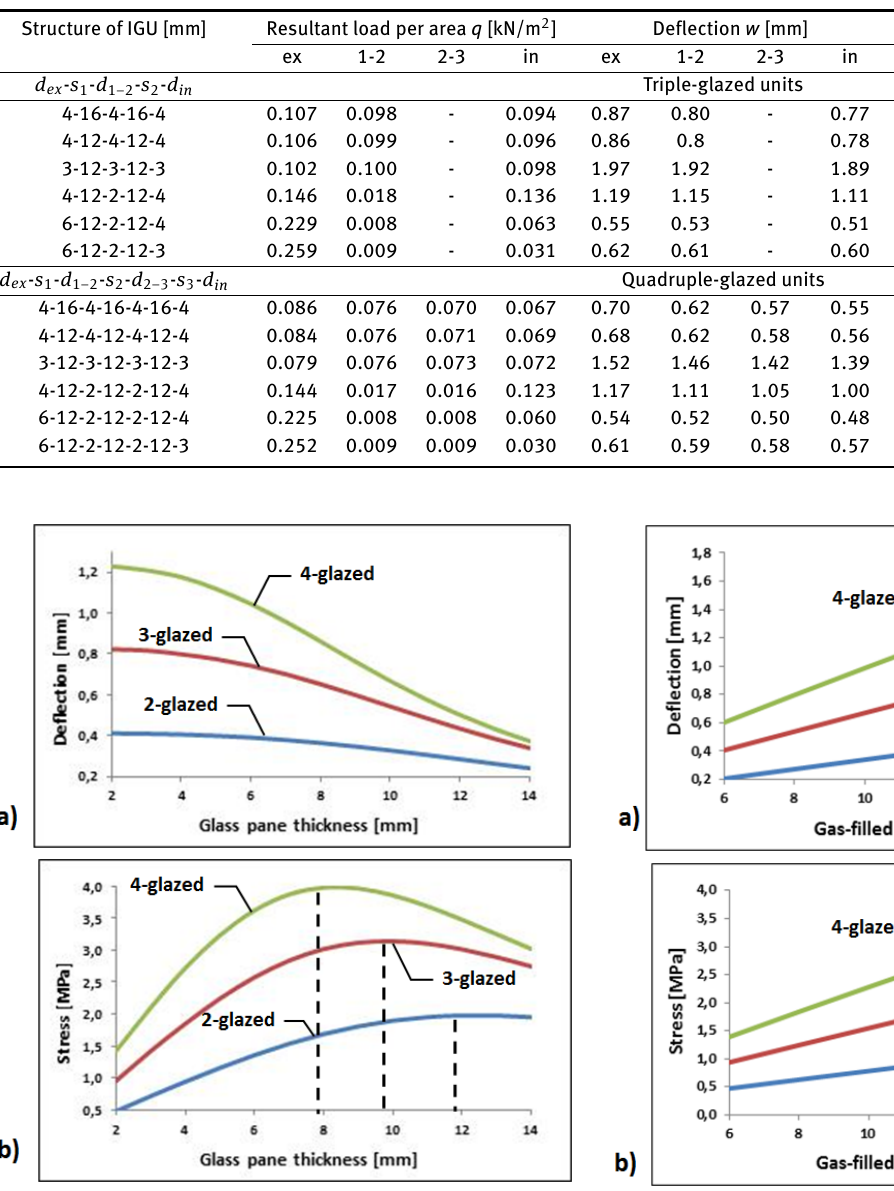
Figure 7: Influence of gas-filled gaps thickness on: a) deflection,